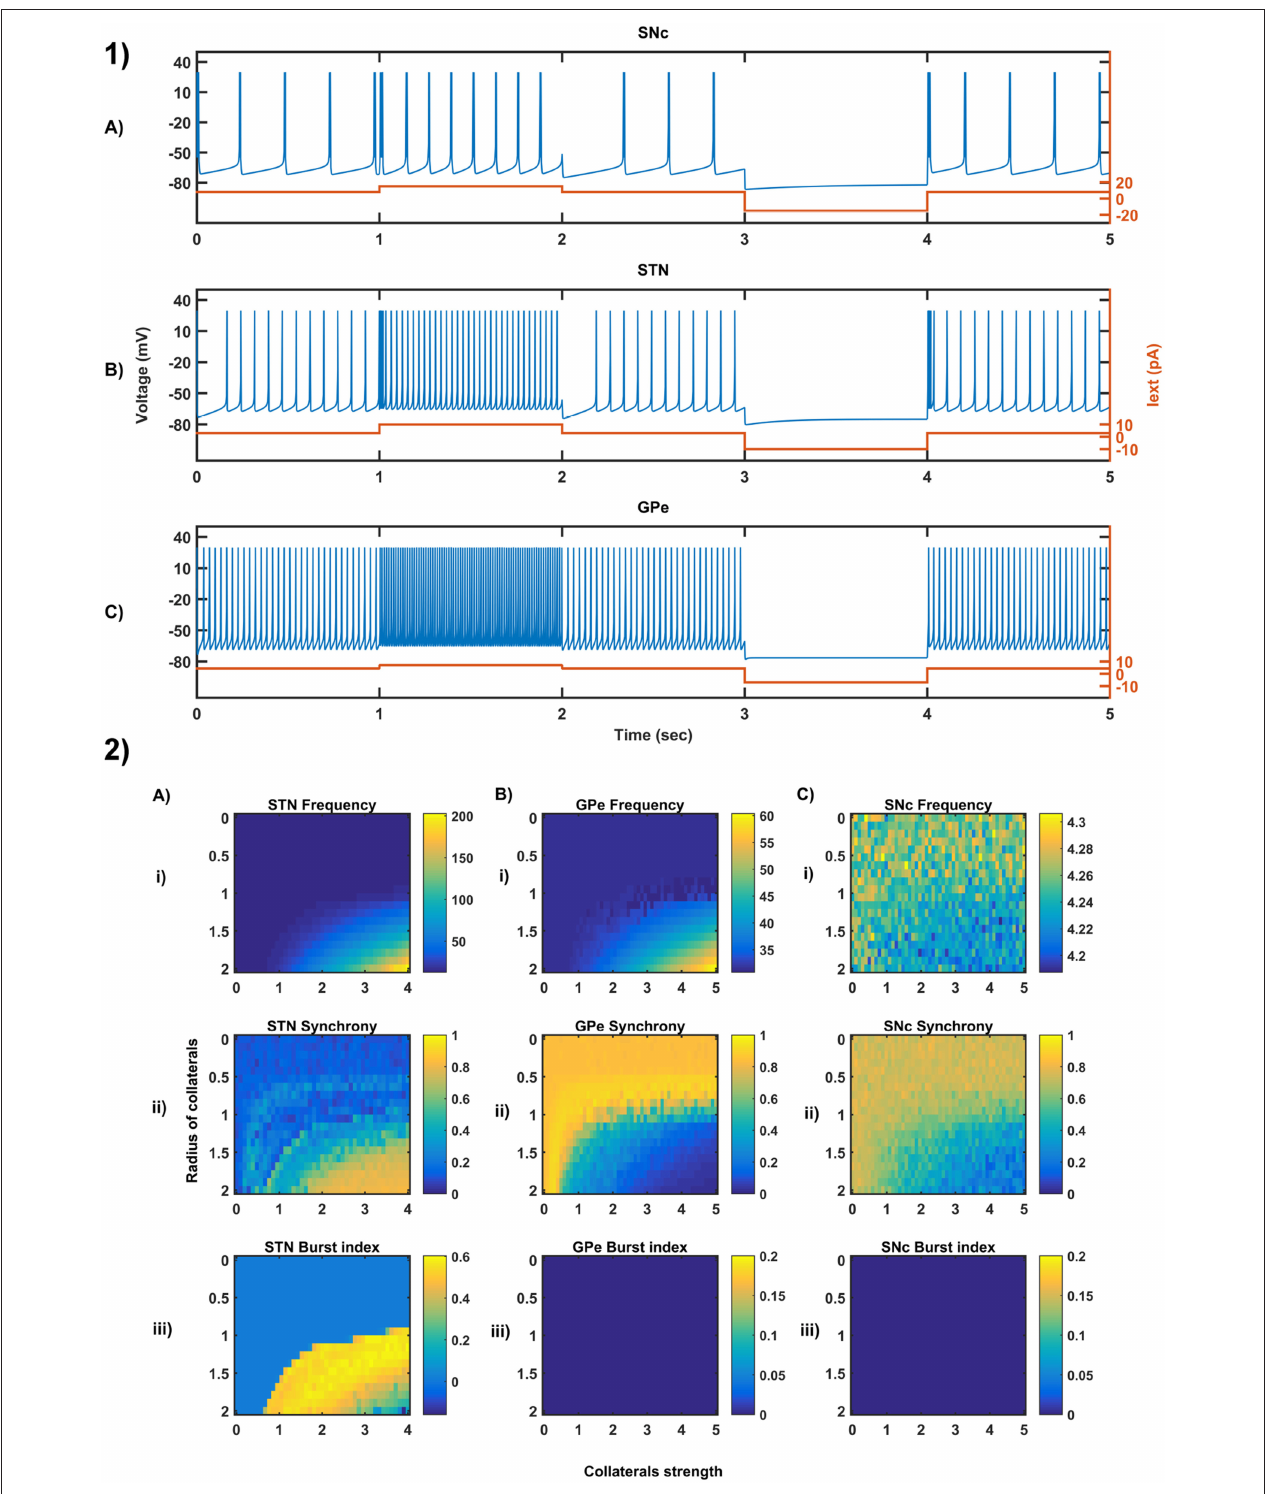
FIGURE 3 | Characteristic behavior in the single-neuron and the population of neurons of different neuronal types. (1) Characteristics firing patterns of SNc (A) , STN (B) , and GPe (C) for varying external currents (orange line - current in picoAmpere (pA)). (2) The response of STN (A) , GPe (B) , and SNc (C) populations for varying lateral connection strength ( A x ) and radius ( R x ) at the level of network properties [Frequency (i) , Synchrony (ii) , Burst Index (iii) ]. I ext , External current applied; STN, SubThalamic Nucleus; SNc, Substantia Nigra pars compacta; GPe, Globus Pallidus externa.